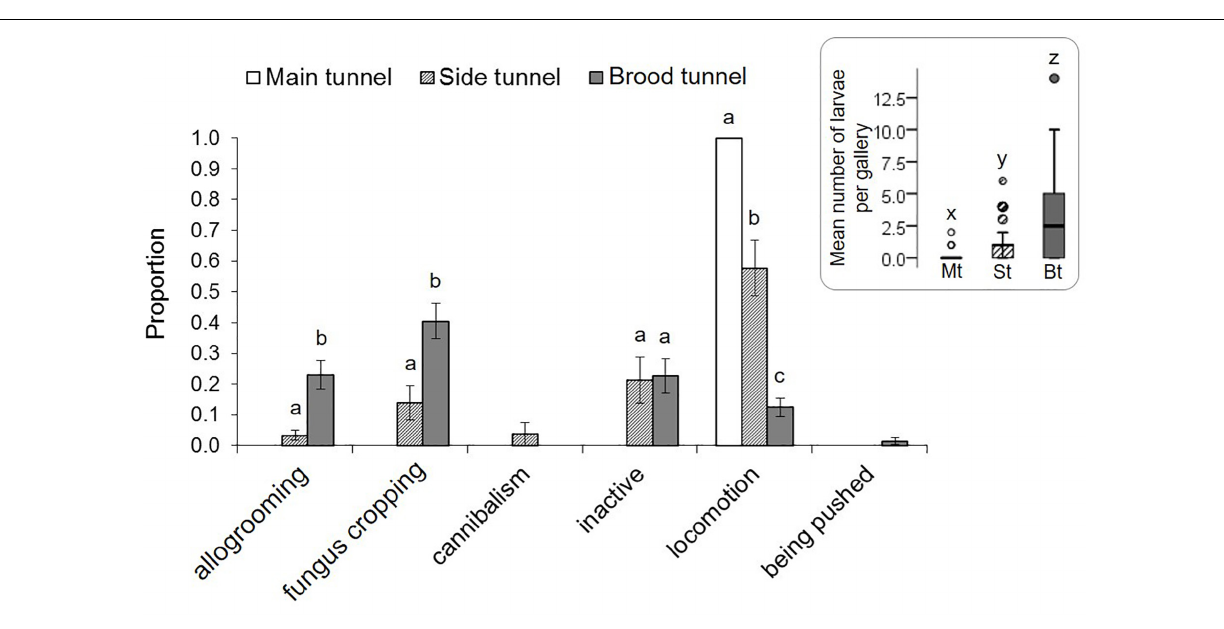
FIGURE 3 | Behaviors of X. affinis larvae in the three gallery compartments. Mean ± SE; different letters denote significant differences ( p < 0.05; for exact values see Supplementary Table S4 ) in pairwise comparisons between compartments. The Mean ( ± SE) numbers of larvae observed in the three compartments are given in the box on the